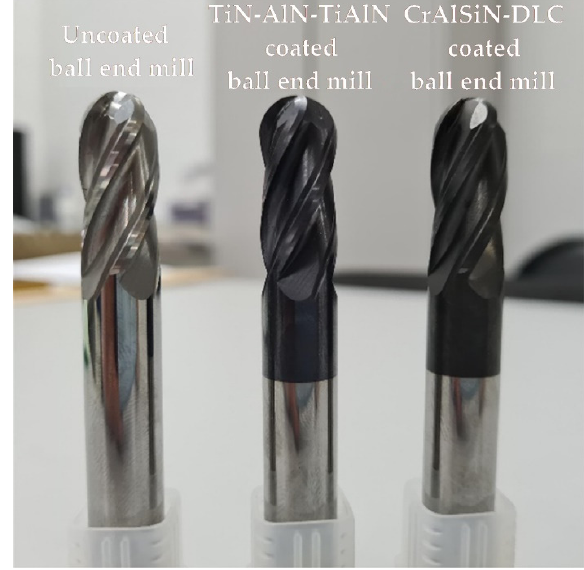
Figure 1. Design of end mills used in research.